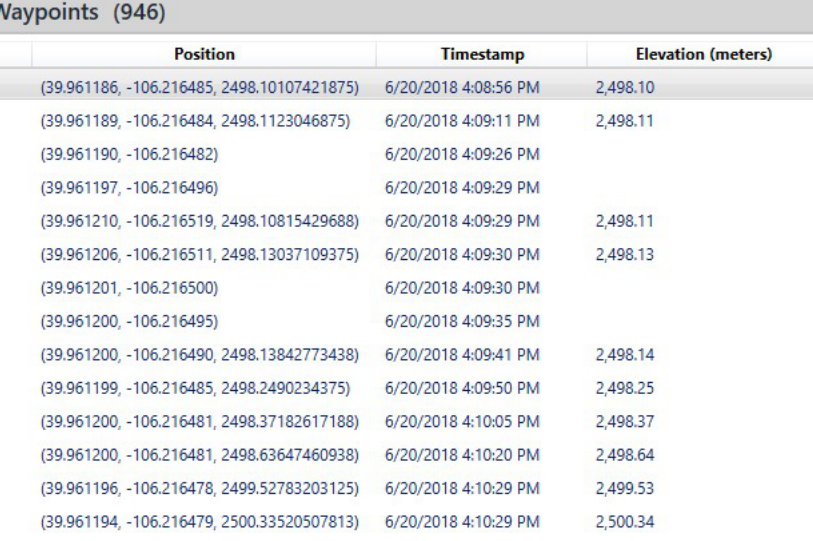
Figure 4. Cellebrite decrypted and parsed 946 waypoints out of 17,998